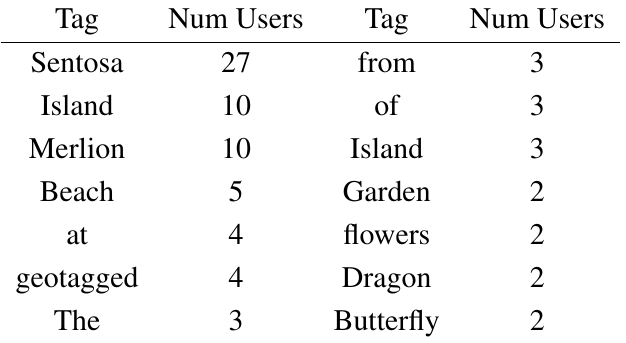
Sample tags associated with geotagged images returned for “Sentosa Island” query